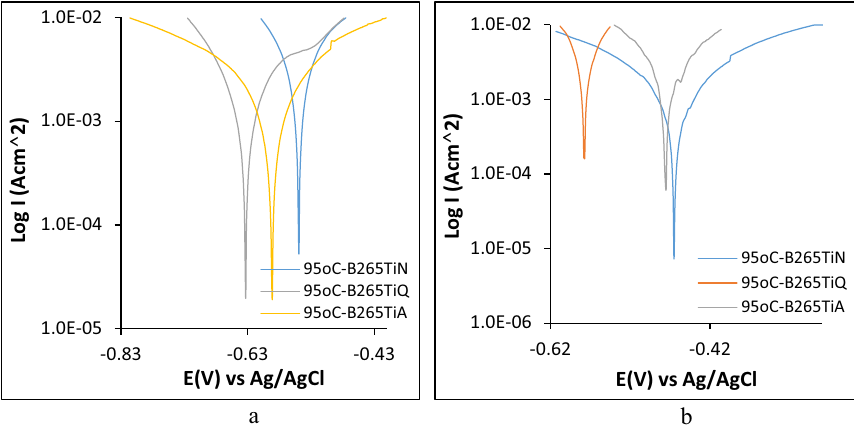
Figure 3: Potentiodynamic plots of B265TiN, B265TiQ, and B265TiA corrosion in ( a ) 2 M H 2 SO 4 + 10% NaCl at 95°C and ( b ) 6 M H 2 SO 4 + 10% NaCl at